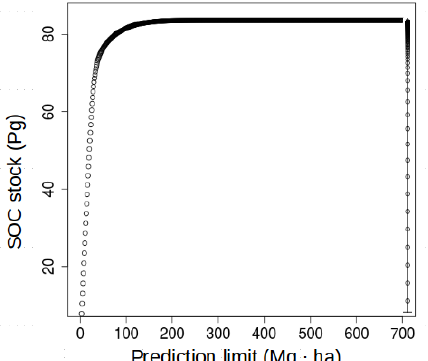
Figure 8. Relationship between the SOC stock and the prediction limit. The average breakdown points of this relationship are shown in the vertical line at the right of the